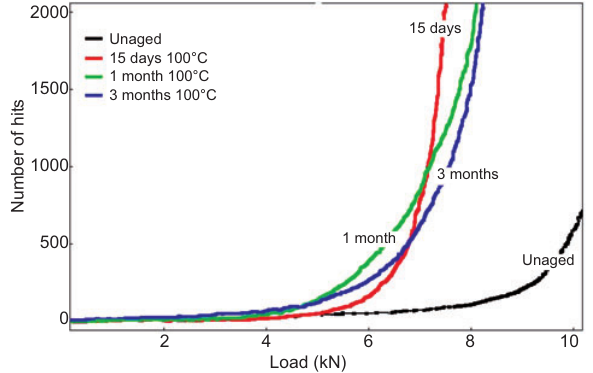
Figure 13 Gravimetry of MS3 and MS4 normalised to the same volume fraction (55 % ) during ageing at 100 ° C. (Figure 15 ). One should bear in mind that the beginning of the acoustic emission for aged MS3 samples appeared around 1000 N from the fi rst sampling (Figure 8 ). For MS4, the load